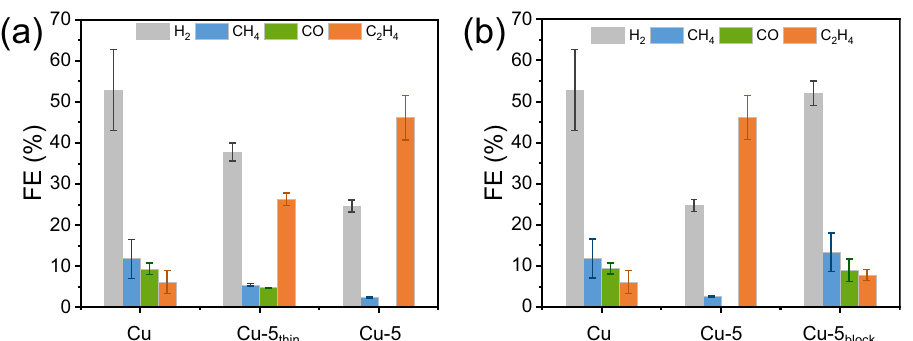
Fig. 4 | Effect of fi lm thickness and porosity. a FEs for H 2 (gray), CH 4 (blue), CO (green),andC 2 H 4 (orange)productionatpristineCu,Cu-5 thin ,andCu-5electrodes. b FEsforH 2 (gray),CH 4 (blue),CO(green),andC 2 H 4 (orange)productionatpristine Cu, Cu-5, and Cu-5 block electrodes. All bulk electrolysis experiments were